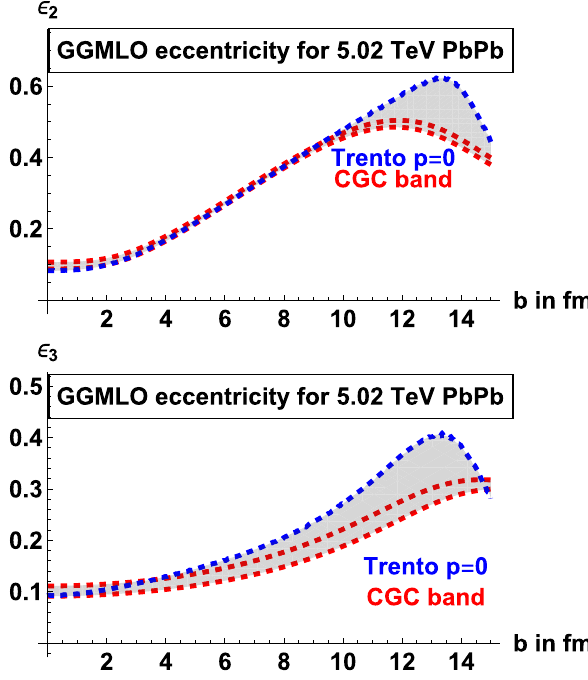
Fig. 9 The centralitydependence of the (second order cumulant) ellip- tic eccentricity (cid:17) 2 = (cid:17) 2 { 2 } (upper plot) and triangular eccentricity (lower plot) for two models discussed in the text. Data taken from Ref. [92] and displayed over a wider range of impact parameter. The grey bandisusedtocharacterizethemodel-uncertaintyoftheseeccentricities in the following